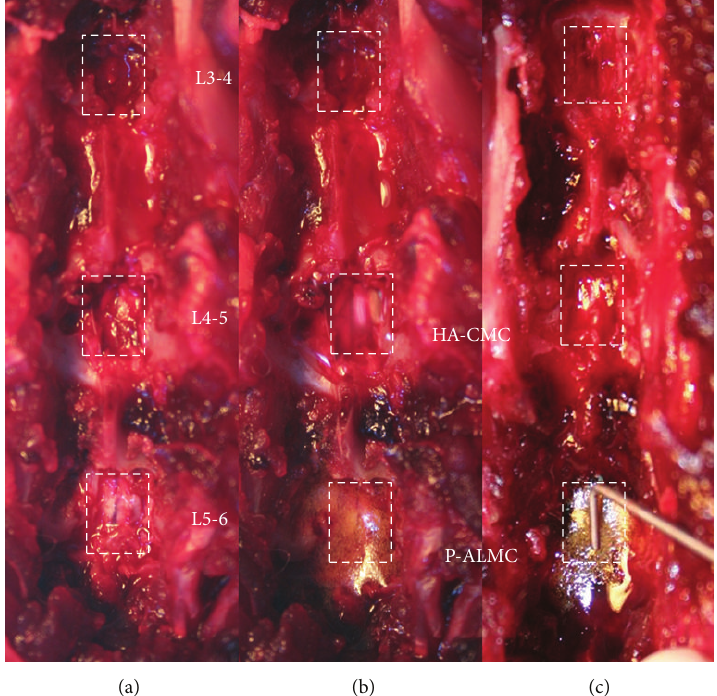
Figure 2: Operative fields in a rabbit model. (a) Pretreatment laminotomy windows. (b) After conditioning according to randomization, at L3-4 (control, group I), L4-5 (HA-CMC, group II), and L5-6 (P-ALMC, group III). (c) The consolidation at only outer surface of the